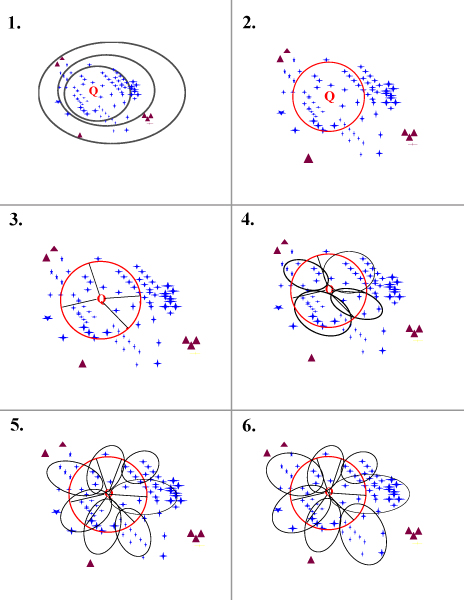
The FlowerPower algorithm. "Q" indicates the query (or seed) sequence. Sequences sharing the same domain structure are indicated as blue stars; all other sequences are indicated as brown triangles. SCI-PHY subfamilies are indicated by black ovals. 1. Identify a set of potential homologs S using PSI-BLAST; filter to remove much longer or much shorter sequences. 2. Select a core set for initial alignment. 3. Identify subfamilies using SCI-PHY and construct subfamily HMMs (SHMMs). 4. Score S with the SHMMs, and identify those sequences receiving scores with E-values below cutoff. Align each sequence to its closest SHMM. Evaluate the alignment with user-specified criteria; remove sequences that do not meet these criteria. 5. Run SCI-PHY on the new alignment to identify subfamilies and construct SHMMs. 6. Repeat steps 1–5 until convergence.